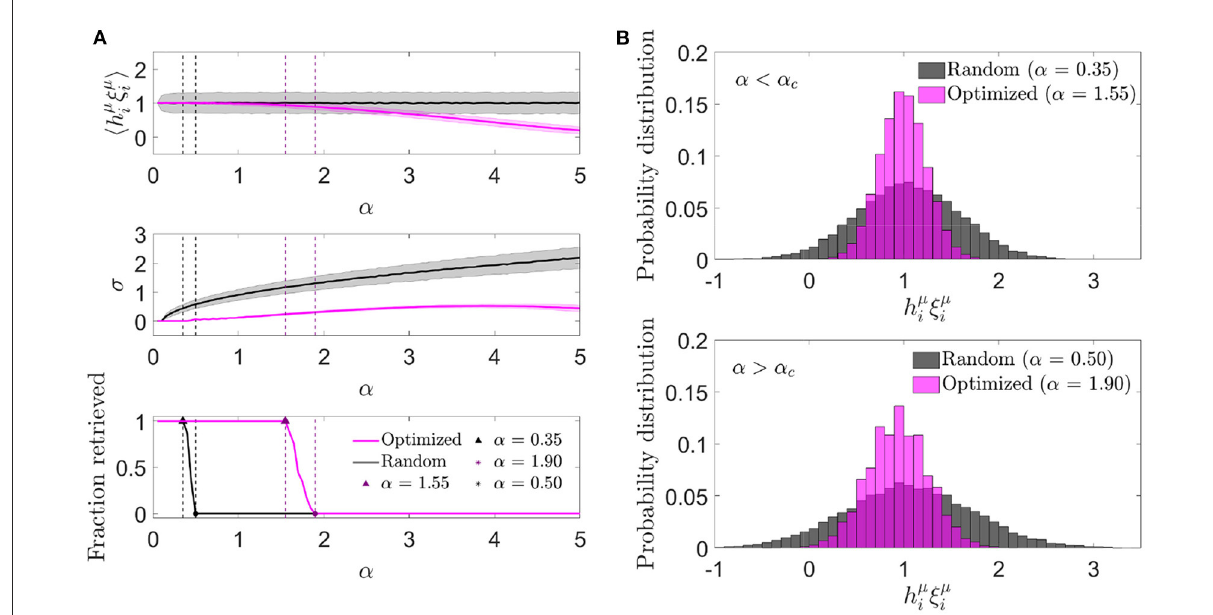
FIGURE3 Noise in optimized networks has a reduced variability at the expense of a negative mean. (A) One representative simulation distribution across neurons of the average (top) and standard deviation (center) of the aligned local field (mean ± s.d.), together with the fraction of retrieved patterns (bottom) as a function of the memory load, for optimized (magenta) or random (black) networks. (B) Distribution of the aligned local field for specific memory loads slightly lower (top) and higher (bottom) than the storage capacity [indicated in (A) ] for both kinds of network (same color code). All plots correspond to networks with N = 2,000 and c = 20.